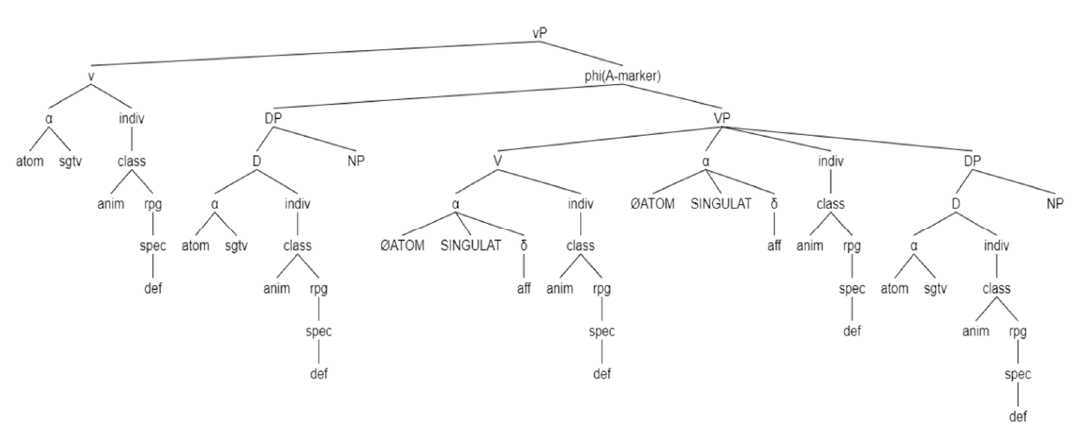
Figure 29. After insertion of v*, inheritance, Agree, and labeling. 35